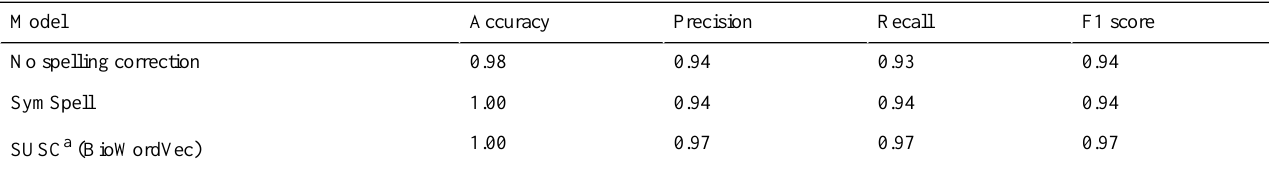
Table 4. Model performance using